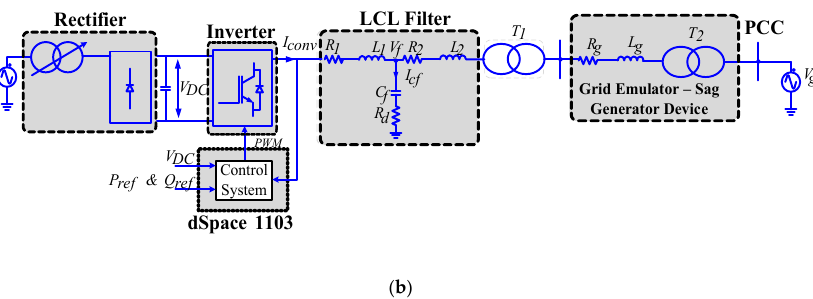
Figure 15. Experimental Setup: ( a ) Experimental setup in the lab; ( b ) Block diagram of the experimental setup.